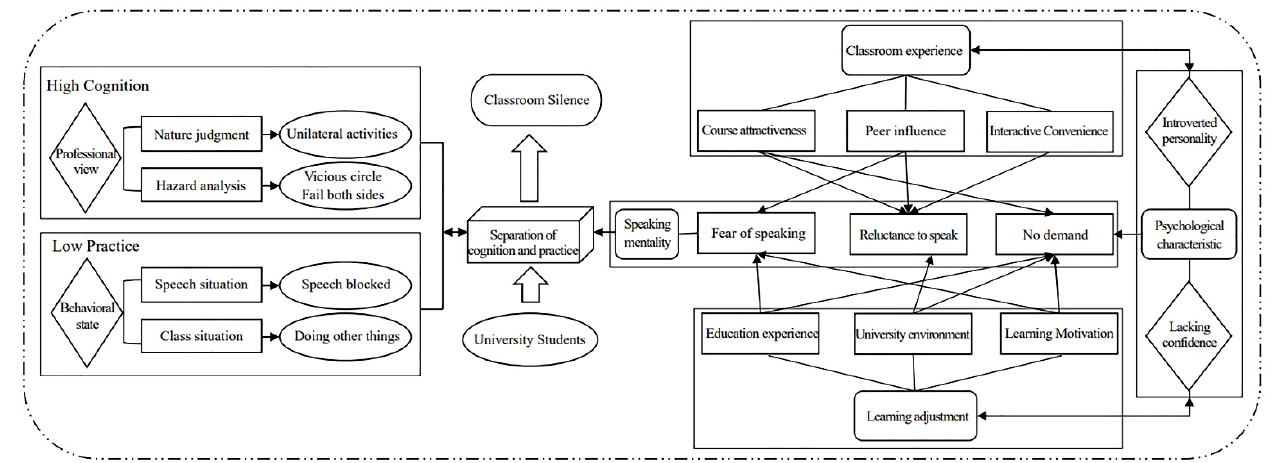
Figure 5. Model diagram of the formation and development of the cognition and practice separation in the classroom silence of Chinese undergraduates majoring in education.